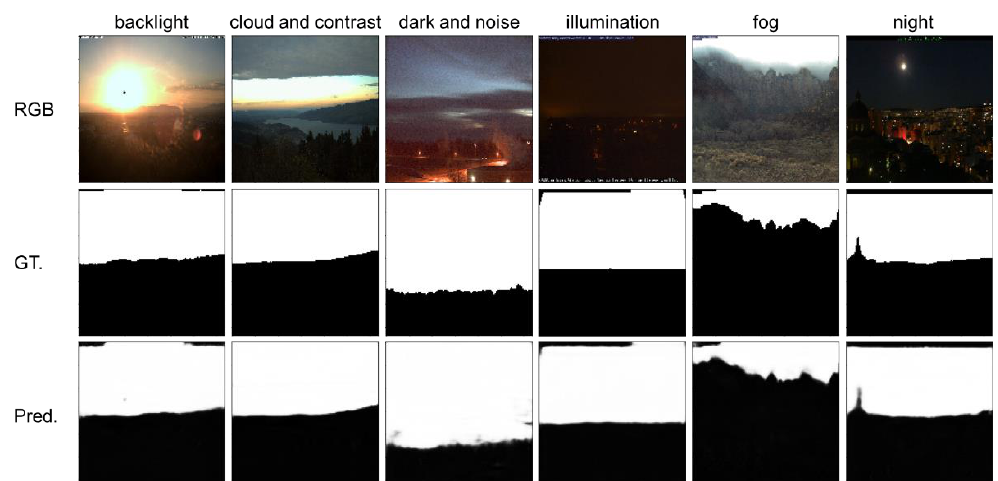
Figure 10. The sky and ground segmentation results of the pre-trained network in many difficult scenes. “RGB”, “GT.”, and “Pred.” refer to the input source images, the ground-truth annotations, and the predictions of the proposed NI-U-Net, respectively. “backlight”, “cloud and contrast”, “dark and noise”, “illumination”, “fog”, and “night” refer to some example difficult scenes in the Skyfinder dataset.